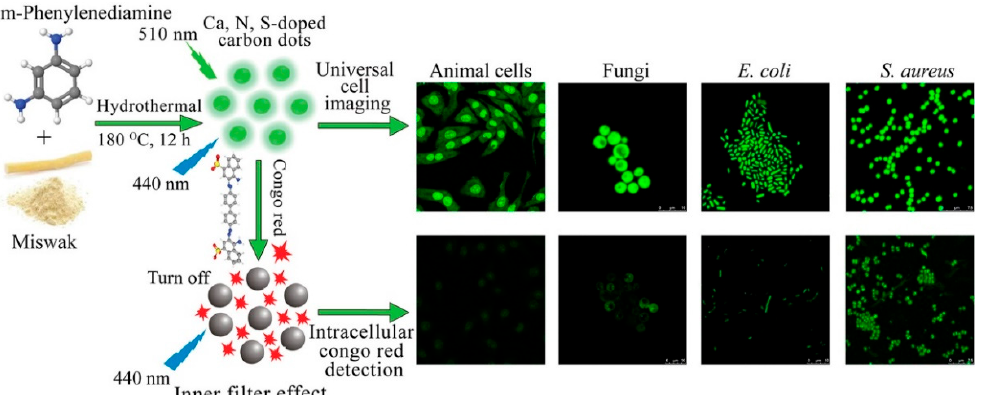
Figure 13. Synthesis of Mis-mPD-CD and their application for cell-imaging and intracellular CR sensing (reprinted with permission from [163], 2022, Elsevier).